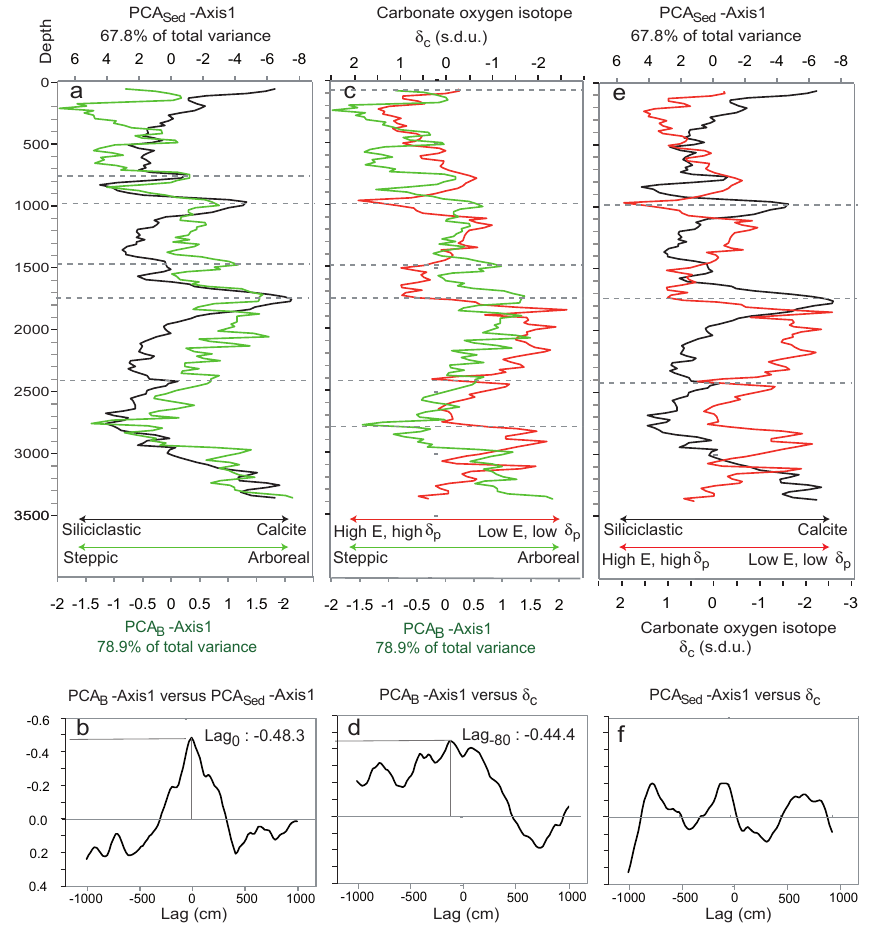
Fig. 9. Relationships between pollen, sediment properties and isotope data. (a) PCA B -Axis 1 and PCA Sed -Axis 1 scores versus depth. (b) Cross correlation between these two depth series. (c) Carbonate oxygen isotope, δ c (in standard deviation units, s.d.u.) and PCA B -Axis 1 versus depth. (d) Cross correlation between these two depth series. (e) PCA Sed -Axis 1 and δ c (in standard deviation units, s.d.u.). (f) Cross correlation between these two depth